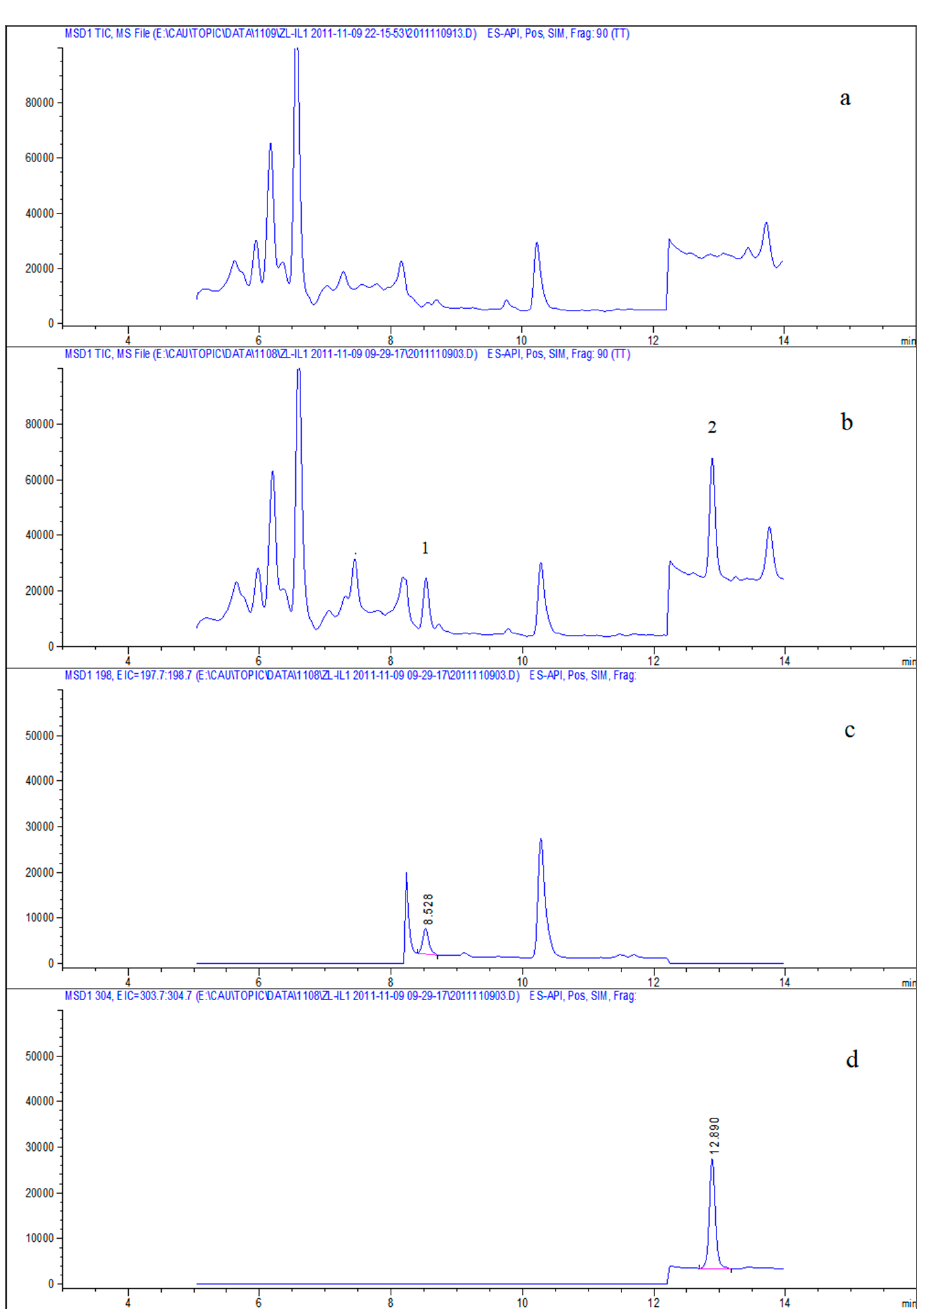
Figure 6. Chromatograms of analytes spiked in the water sample. ( a ) Sum chromatogram of blank, ( b ) sum chromatogram of spiked water, ( c ) extracted ion chromatogram (EIC) of ion 198, and ( d ) EIC chromatogram of ion 304. 1-Irgarol 1051, spiked 0.02 µg L − 1 ; 2-Sea-Nine 211, spiked 0.12 µg L − 1 .